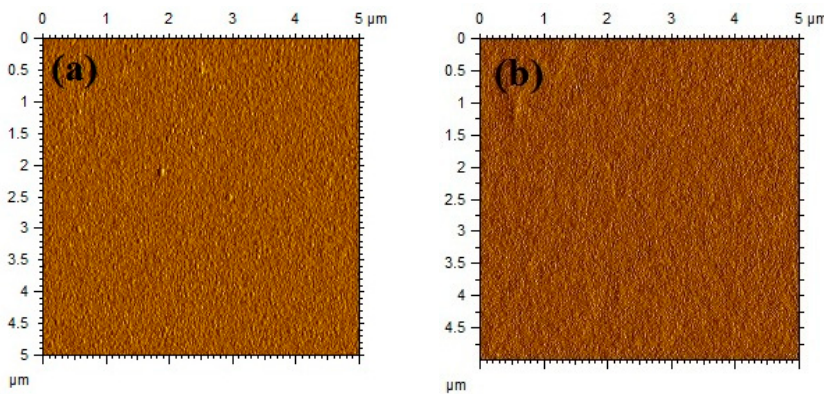
Figure 2. The atomic force microscopy (AFM) of the surface of ZnO films with and without SF 6 plasma treatment, ( a ) without passivation, ( b ) with passivation.